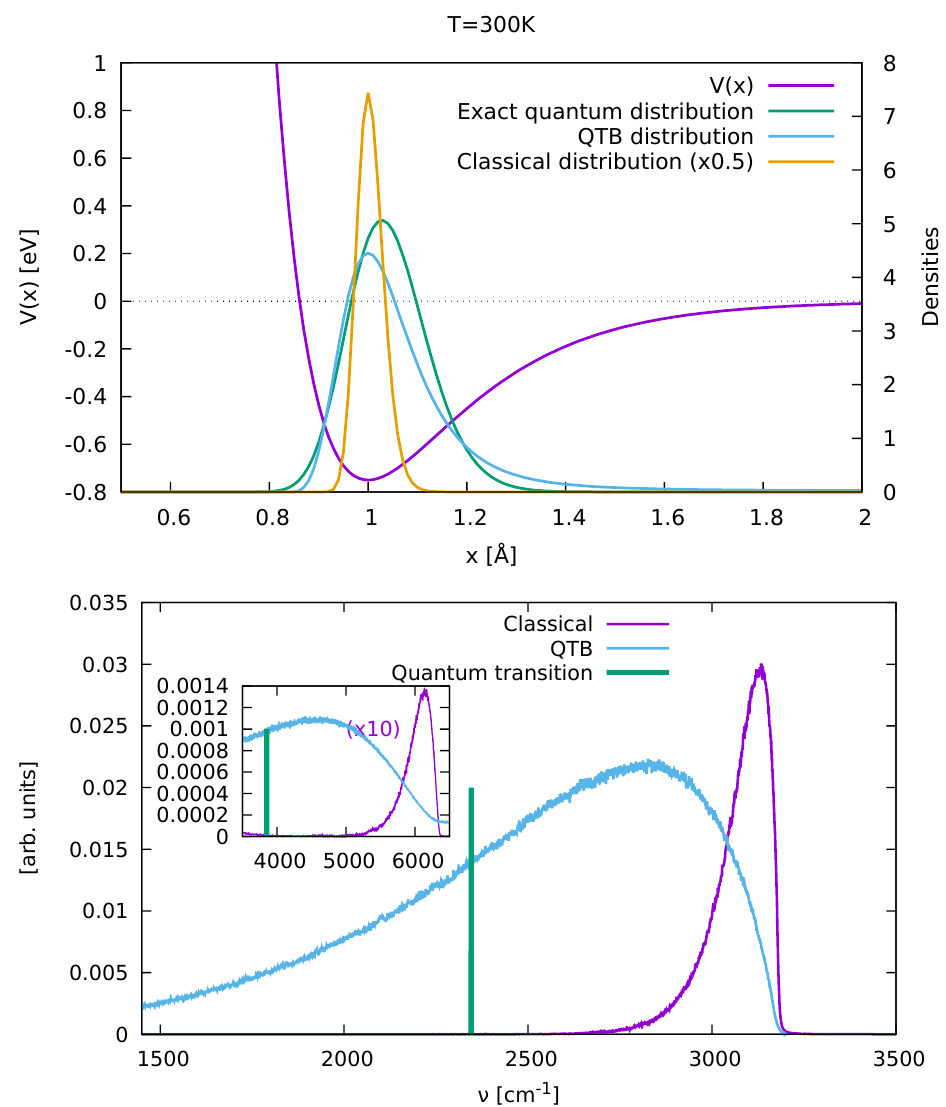
Figure 5. Probability distributions ( top ) and C vv ( ω ) spectra ( bottom ) for the strongly anharmonic Morse potential, for the classical MD simulation (magenta), the QTB (blue) and the first quantum transition between the ground state and first excited state (green). The inset shows show the overtones. Note that the classical spectrum is multiplied by a factor of